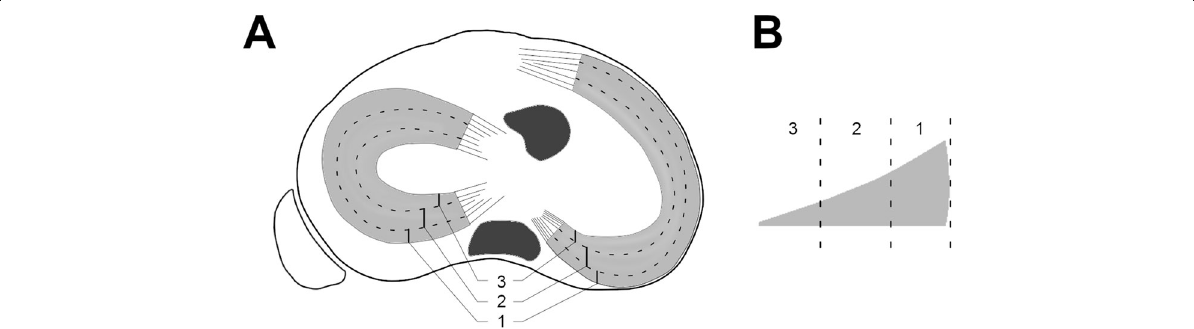
Fig. 1 Meniscal zones according to [3, 31]. a Proximal view of the tibial plateau. b Cross-sectional area of a representative meniscus. The dotted lines divide the menisci into three different zones: 1, peripheral zone; 2, middle zone; 3, central